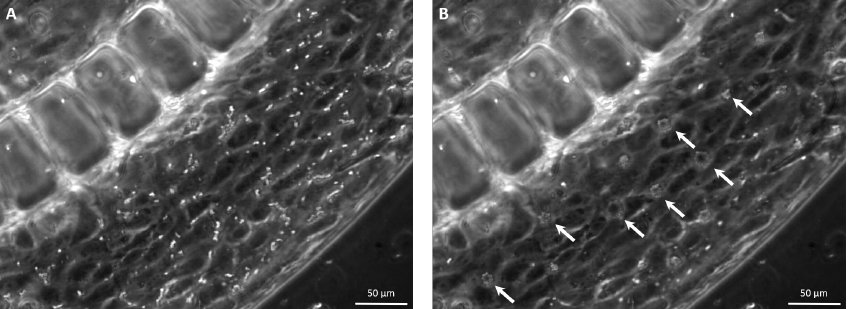
Figure 8. Phase contrast images showing the events related to US exposure in the blood vessel model. The images show a portion of the vascular channel, where MBs have been injected. ( A ) Prior to irra- diation, MBs appear as homogeneously-distributed, dispersed particles. ( B ) Upon US exposure, MBs respond to the acoustic pressure by aggregating and forming evenly-spaced clusters (white